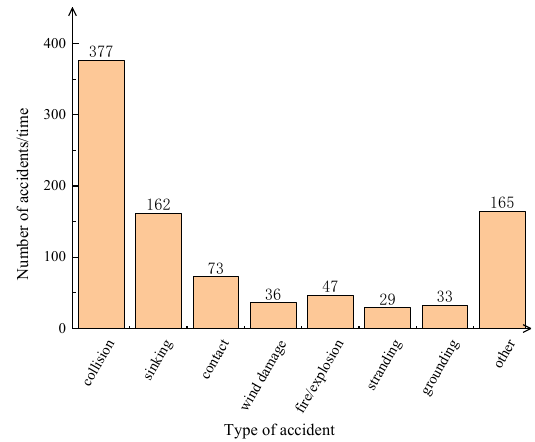
Figure 2. Occurrences of different types of accidents.